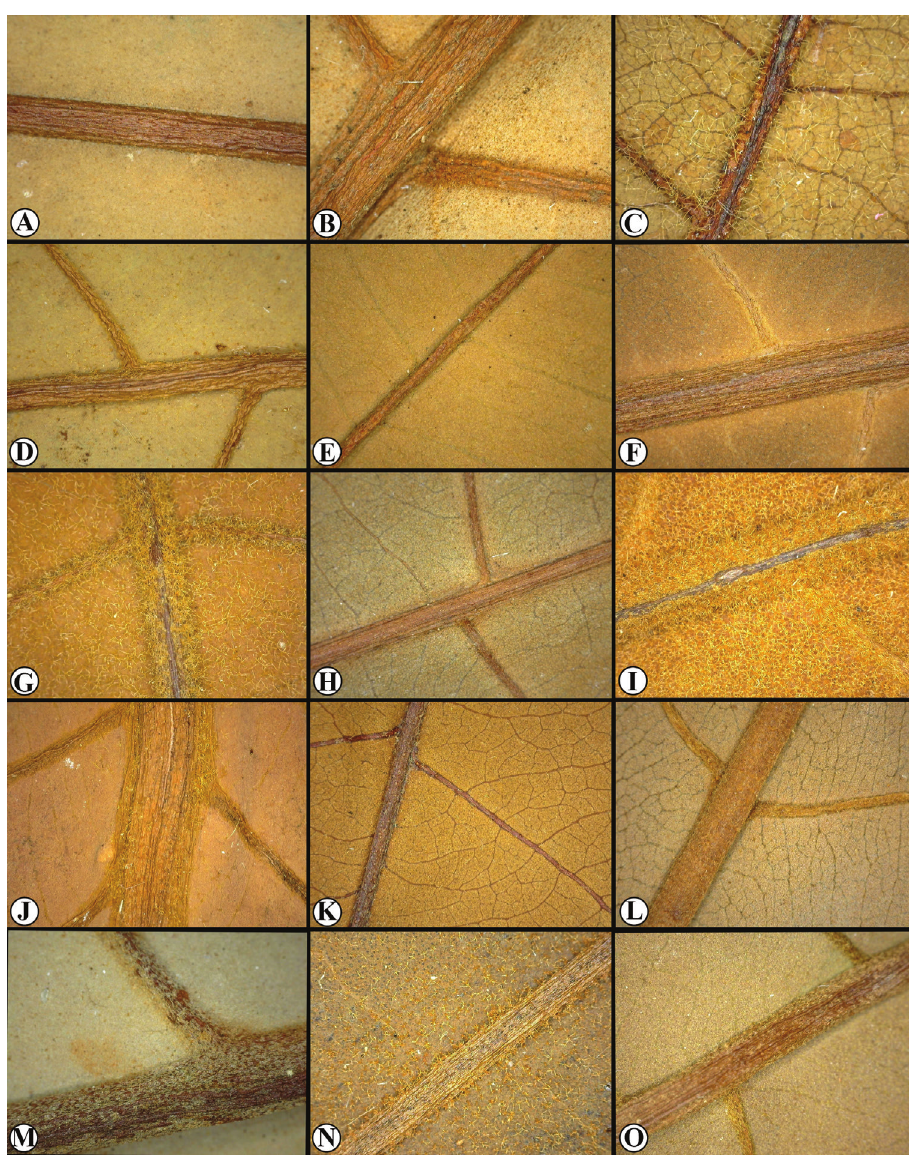
Figure 3. Trichomes in Mesoamerican Virola A Virola allenii ( R. Aguilar 2224, MO) B V. amistadensis ( G. McPherson 8703 , MO) C V. chrysocarpa ( O. Valverde 970 , MO) D V. elongata ( G. McPherson 13674 , MO) E V. fosteri ( G. McPherson 20913 , MO) F V. guatemalensis ( R. Cedillo 3349 , MO) G V. koschnyi ( R. E. Gereau et al. 3455 , MO) H V. laevigata ( R. Aguilar 2004, MO) I V. megacarpa ( J. A. Duke 15261 , MO) J V. montana ( E. Bello 855 , MO) K V. multiflora ( R. Rueda et al. 8196 , MO; inset, J. C. Sandino 3302, MO) L V. nobilis from Barro Colorado ( R. J. Schmalzel 320 , MO) M V. otobifolia ( G. de Nevers & H. Herrera 7056 , MO) N V. sebifera ( F. Almeda et al. 5553 , MO) O V. nobilis from Osa Peninsula ( R. Aguilar 11186 ,